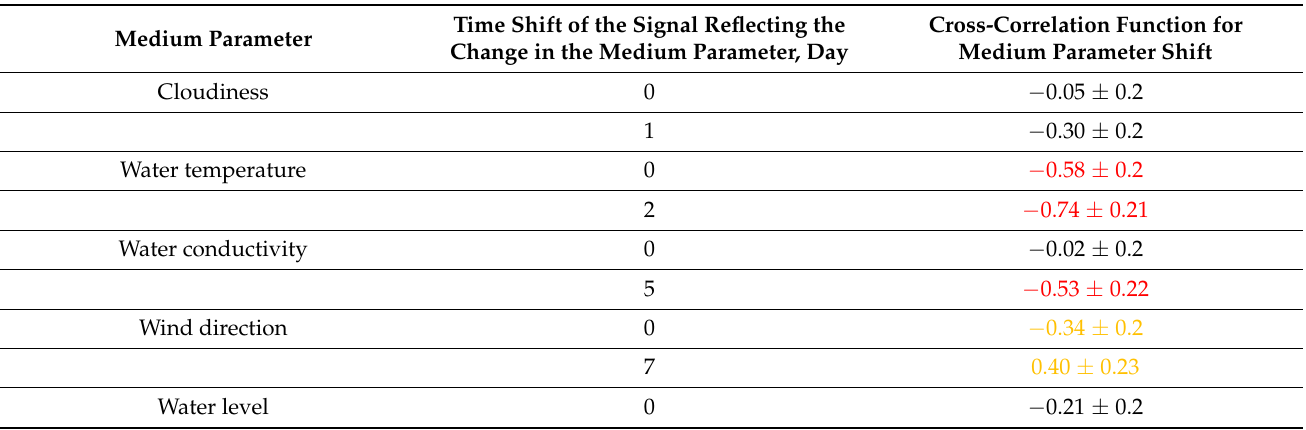
Table 4. Results of the correlation analysis of the diurnal cycle amplitude (4 h) with medium parameters. Red color indicates reliable data, yellow indicates close to reliable ( p ≤